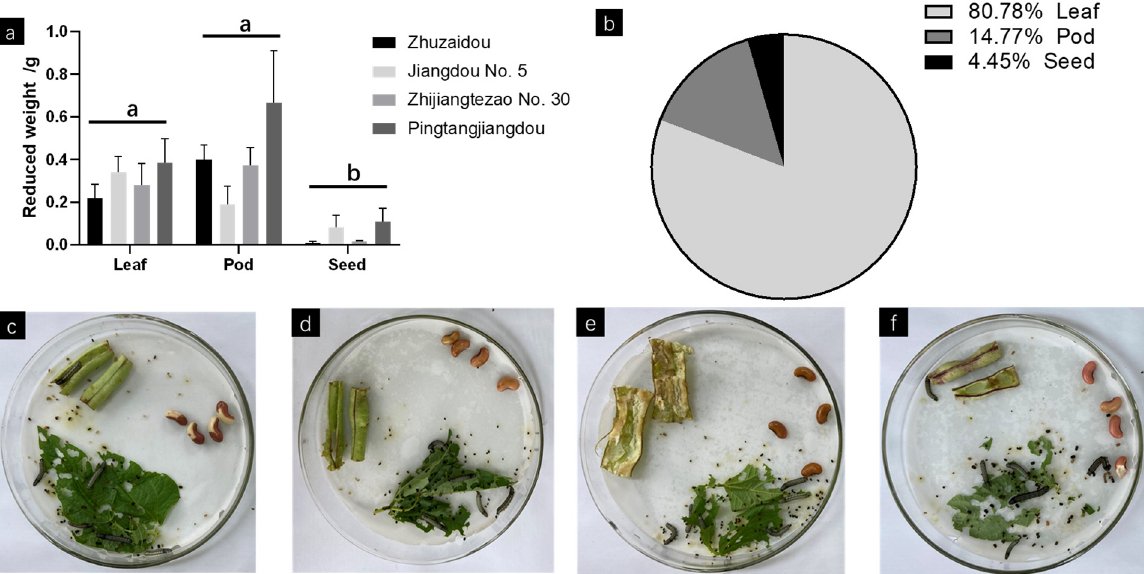
Figure 6. Common cutworm 4th larvae feeding preference experiments between leaf, pod, and seed tissue. ( a ) The bar graph of the weight reduction of yardlong bean organs at 24 h. The same lowercase letter means no significant difference. ( b ) The pie chart of the average number of common cutworm on different yardlong bean organs. ( c – f ). Feeding of different organs of Zhuzaidou, Jiangdou No.5, Zhijiangtezao No.30, Pingtangjiangdou varieties by common cutworm. Zhuzaidou and Pingtangjiangdou are insect-sensitive varieties. Jiangdou No.5 and Zhijiangtezao No.30 are insect-resistant varieties.